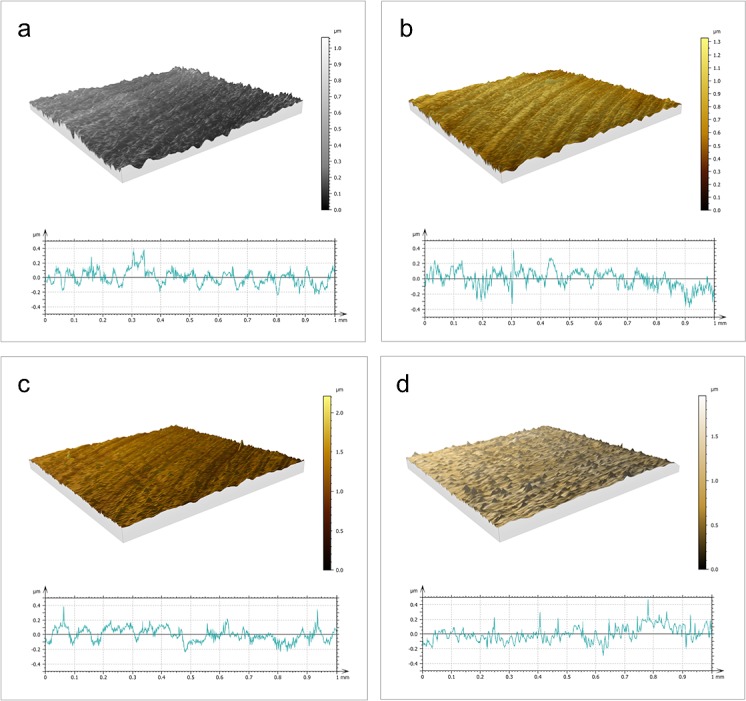
3D maps and related 2D profiles.3D maps and related 2D profiles of: a) machined, b) anodized, c) TiN-coated, and d) ZrN-coated disks.